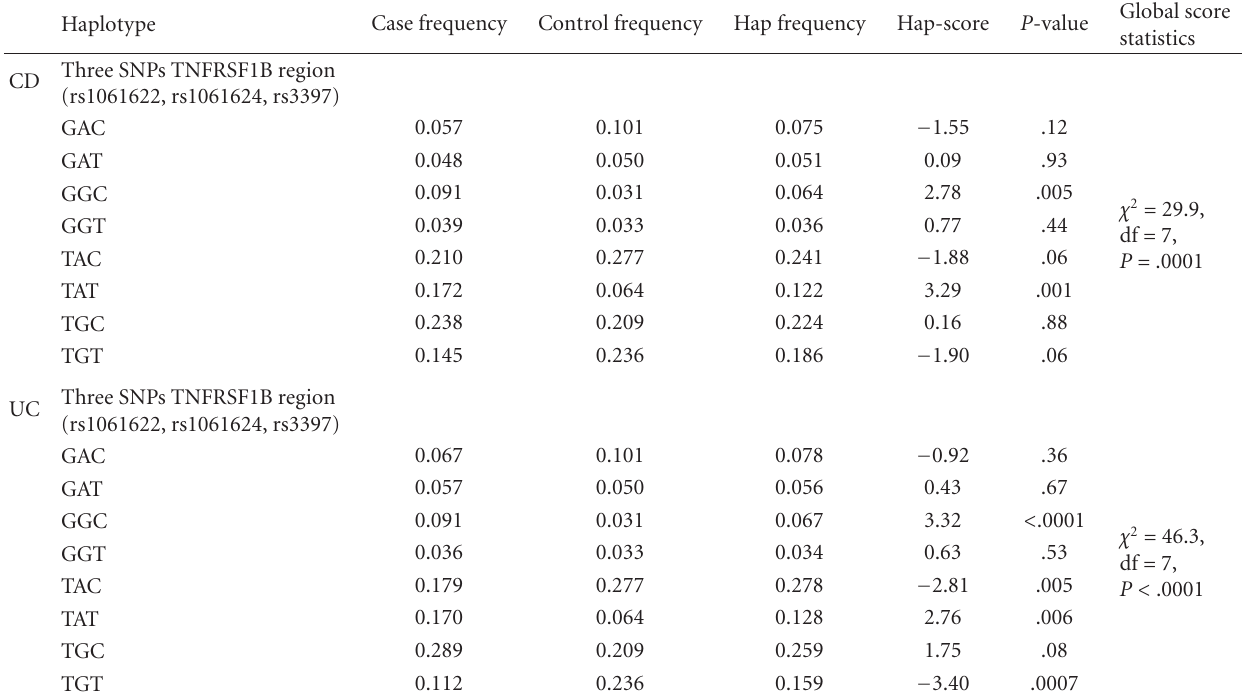
Table 6: Haplotype analysis of three-SNP TNFRSF1B haplotype in IBD status in New Zealand IBD patients and Caucasians.